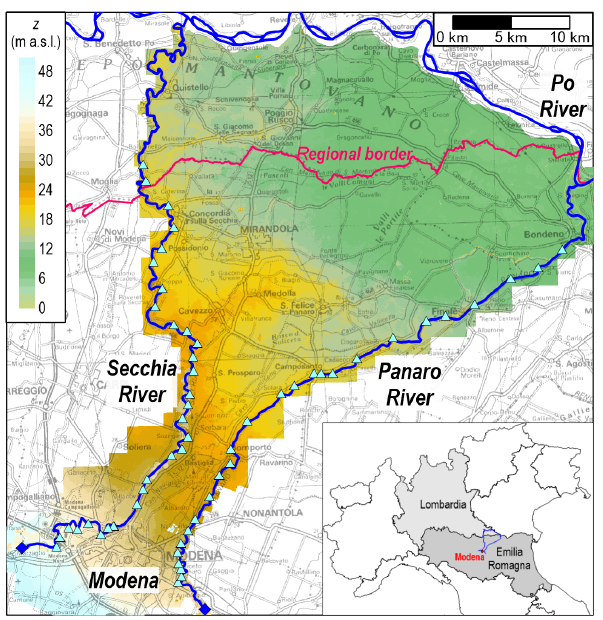
Figure 1. Map of the pilot area (Emilia-Romagna and Lombardia regions, northern Italy): rivers are represented in blue, the breach locations along the Secchia and Panaro rivers are indicated as trian- gles in cyan, and the terrain elevation contour map is also depicted. The topographic map in background is made available by Emilia- Romagna region at https://geoportale.regione.emilia-romagna.it/it (last access: 8 January